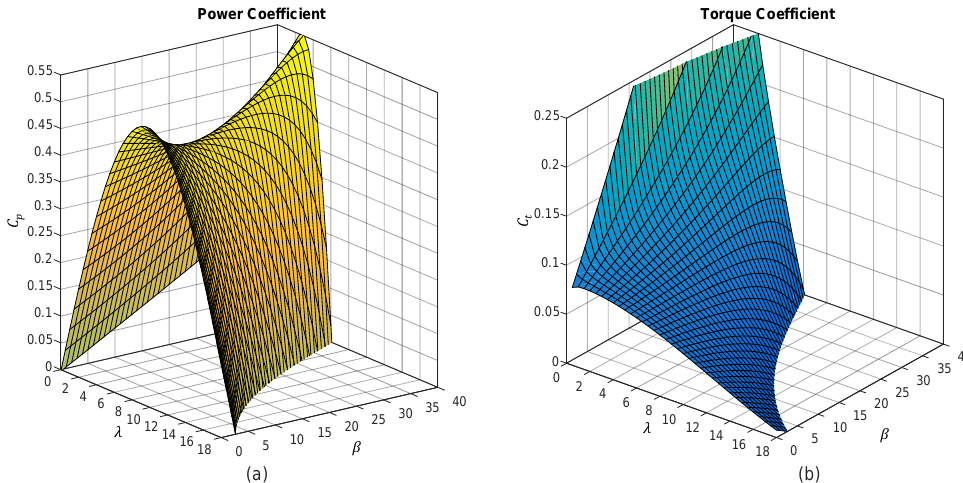
Figure 10. Coefficient proposed by Nouira and Khedher [18], with variations of λ and β ; ( a ) power coefficient, ( b ) torque coefficient.